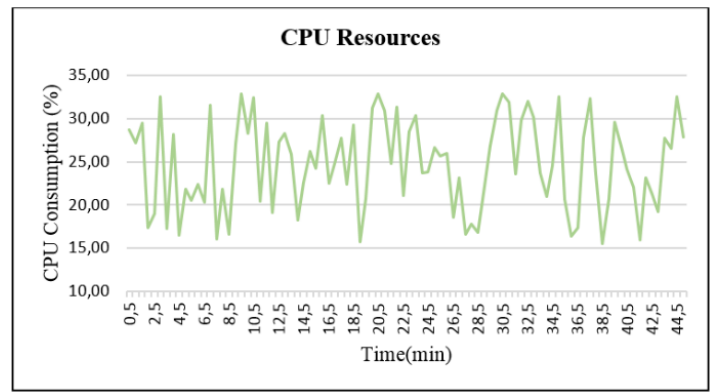
Figure 16. RPI’s CPU